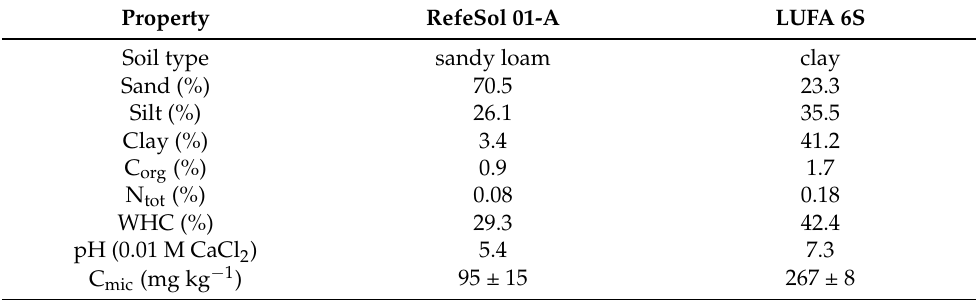
Table 1. Physicochemical and microbial properties of the tested